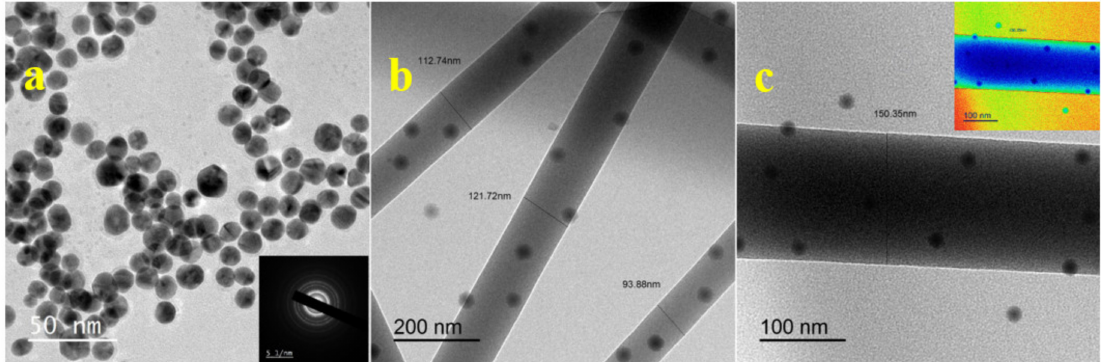
Figure 2. TEM images of ( a ) produced gold nanoparticles from green reduction through Cs from NF3 before electrospinning, ( b ) exhibited NF6 nanofibrous webs with a clear view of entrapped gold nanoparticles, and ( c ) single nanofibers with inverted cross color showing completely miscible Mox inside the sca ff